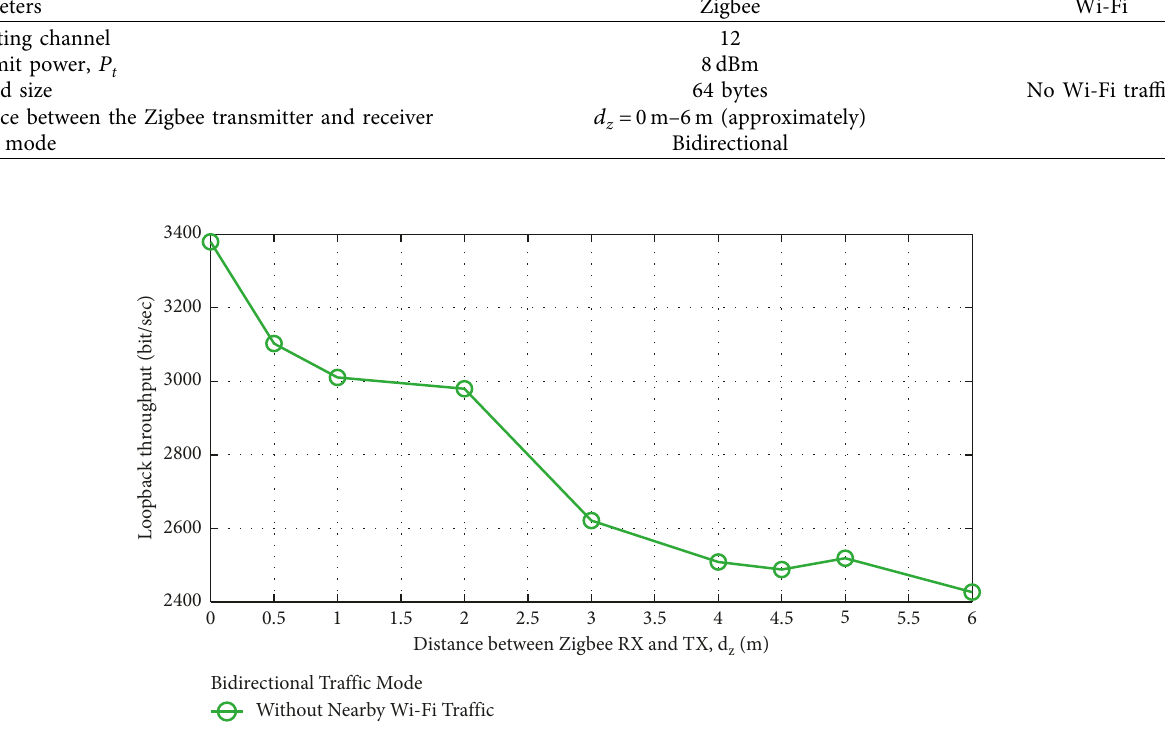
Figure 9: Loopback throughput versus d z without nearby Wi-Fi transmissions. Table 8: Parameters for the experiments in Section 4.2.3